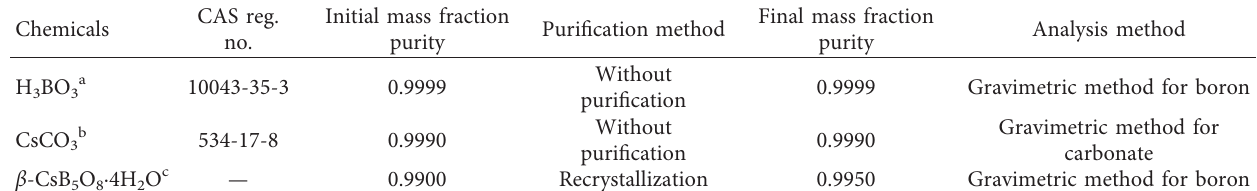
Table 1: Reagents used in the study.